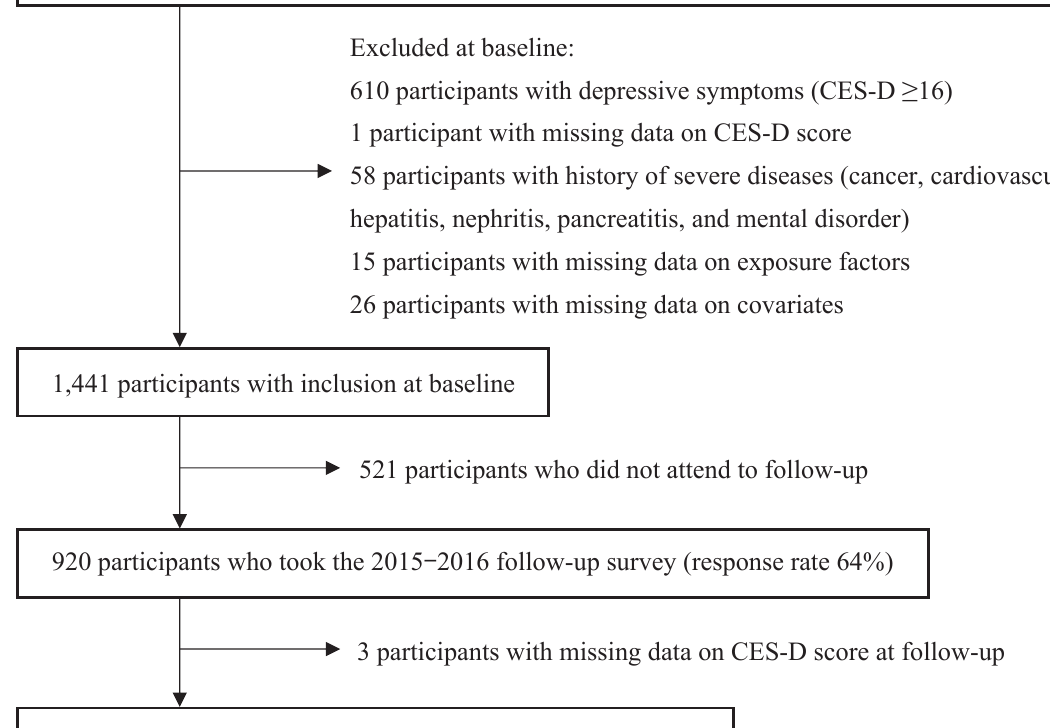
Figure 1. Flow chart of participant